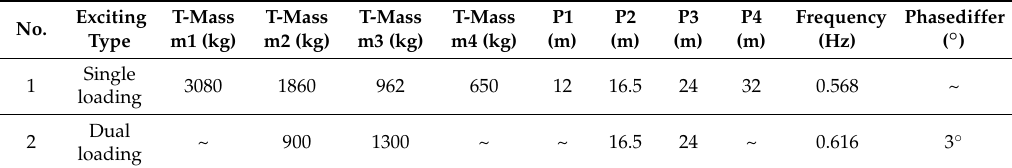
Table 2. Experiment variables of single-point excitation and dual-point excitation.